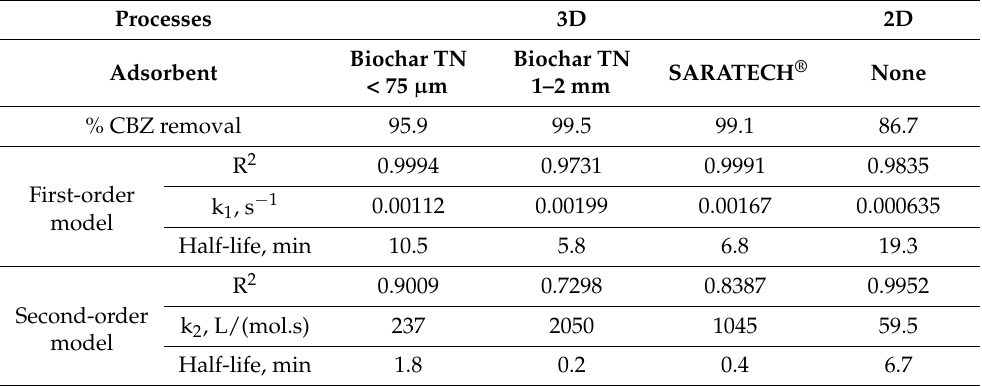
Table 5. CBZ removal efficiency, regression coefficient, rate constant, and half-life as a function of 3D and 2D